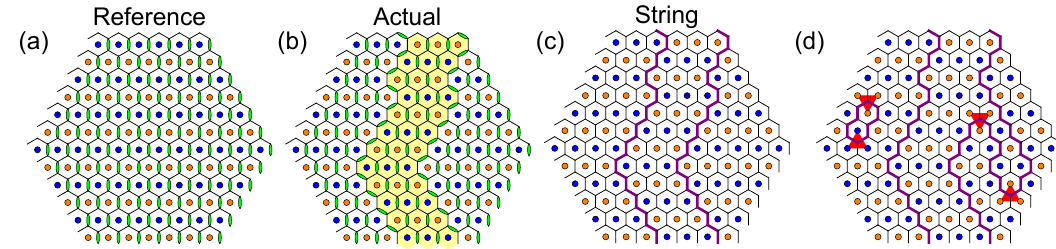
Figure 14: Mapping between Ising configurations on the triangular lattice and string configurations on the honeycomb lattice. (a) Reference Ising configuration. (b) A configuration of interest. Spins that differ from the reference configuration are highlighted in yellow. (c) The configuration of interest can be specified (up to a global spin flip) by a set of strings (purple), which measure the difference in dimer covering between the actual and reference configurations. These strings are always non-crossing, and for configurations within the constrained manifold are directed in the sense that they never turn back on themselves, and therefore wind the system. (d) Defect triangles (red) act as sources and sinks of pairs of strings, and allow strings to turn back on